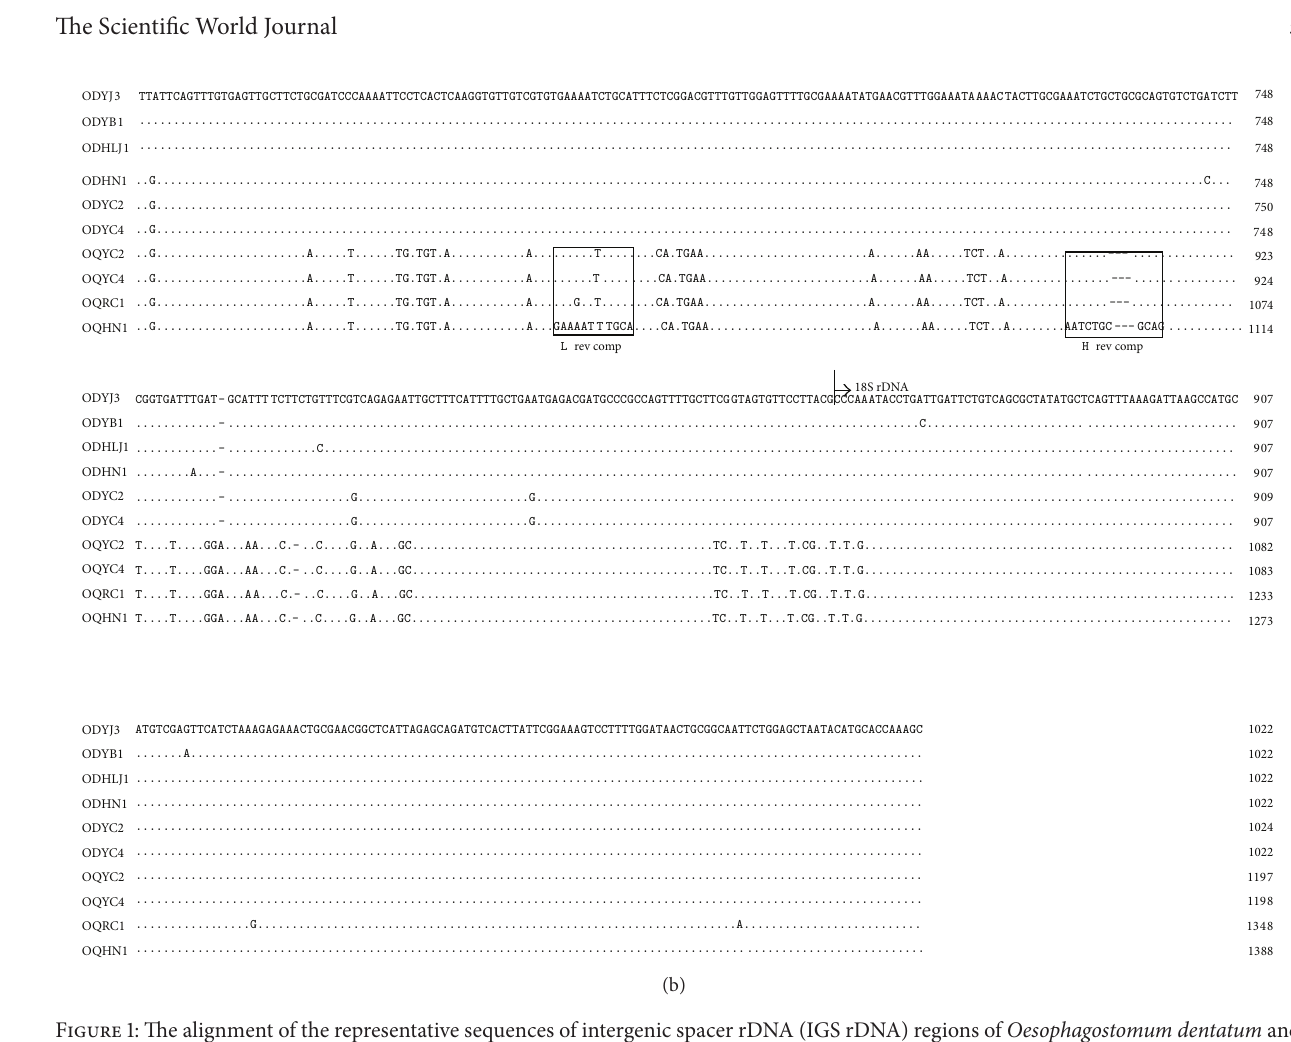
Figure 1: The alignment of the representative sequences of intergenic spacer rDNA (IGS rDNA) regions of Oesophagostomum dentatum and O. quadrispinulatum . Portions of the flanking 28S and 18S genes are shown. Dots ( ⋅ ) denote sequence identity to the first sequence. Dashes (-) represent nucleotide deletions. Motifs for two nematodes are boxed with a solid (or broken) line. See the text for additional